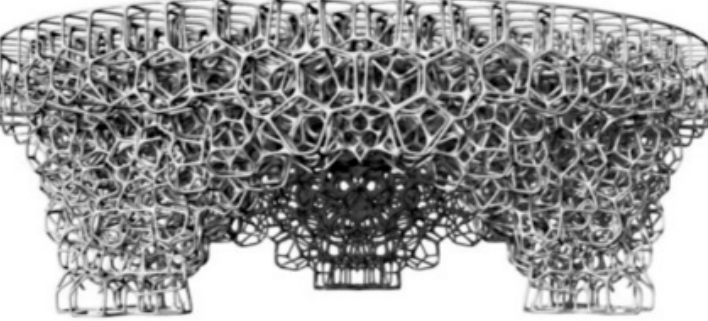
Figure 28. The model of the 3D Voronoi mirror [31].